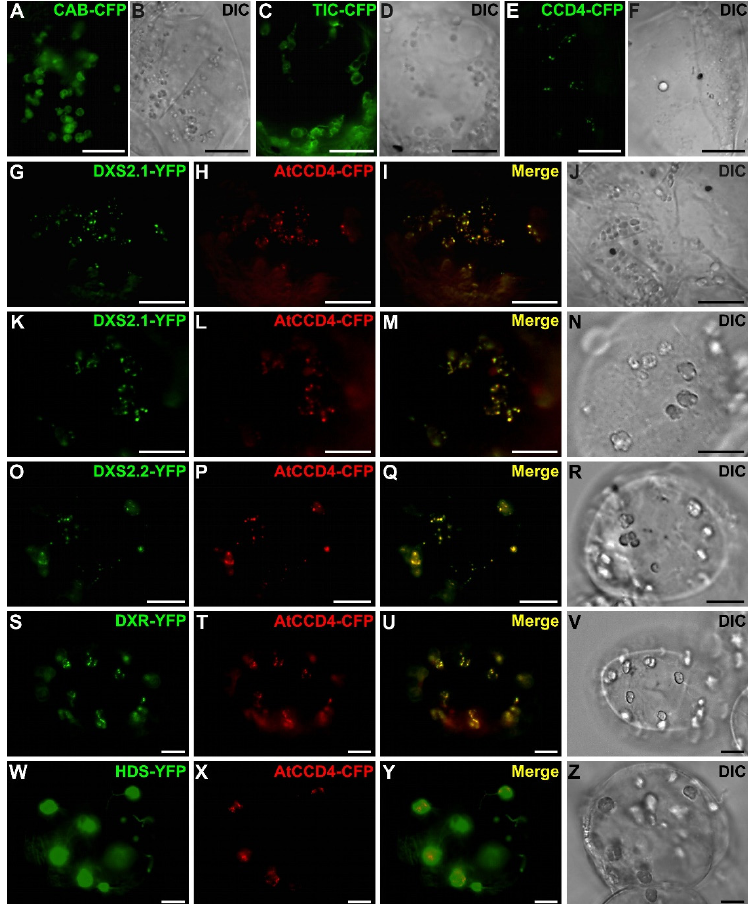
Figure 9. Coexpressions of DXS2.1-YFP, DXS2.2-YFP and DXR-YFP fusions with different plastid